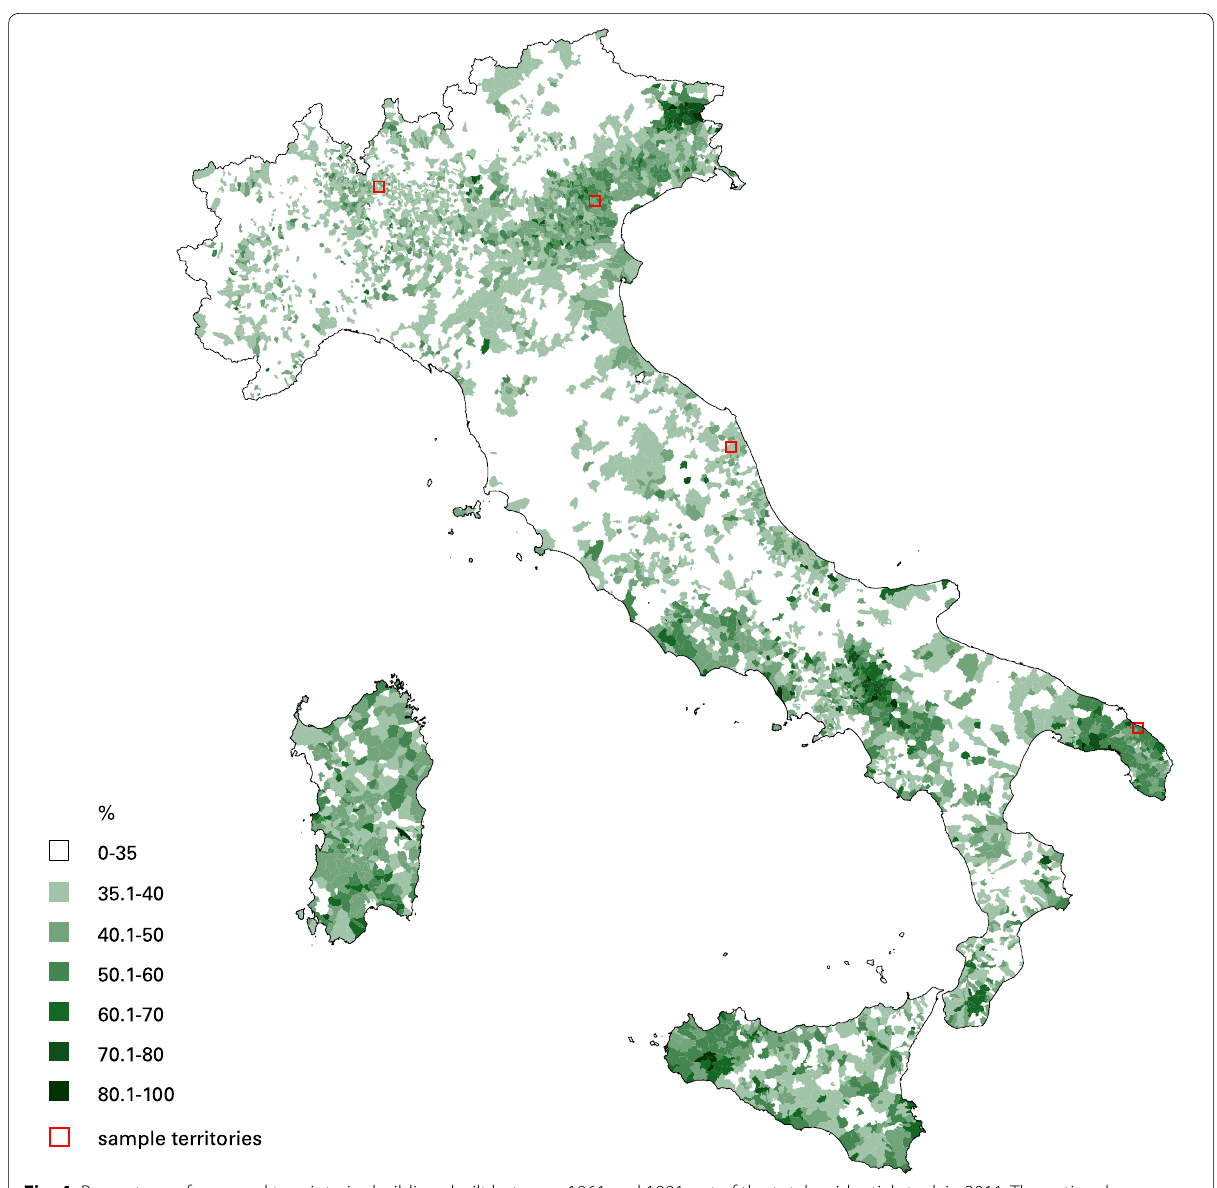
Fig. 4 Percentage of one- and two-interior buildings built between 1961 and 1991 out of the total residential stock in 2011. The national average of this indicator is 35%. Municipalities with an above-average presence of these buildings are highlighted with green hatches. Sample territories described in paragraph n. 3 are also displayed (authors’ calculations on data from Istat